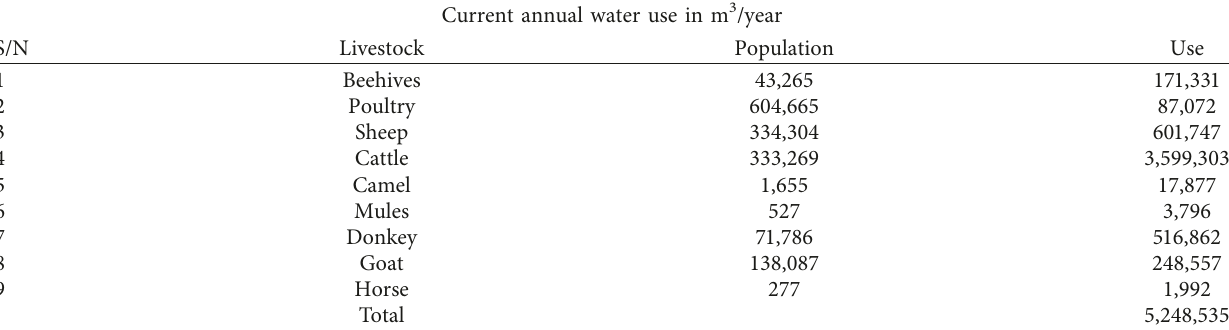
Table 11: Current total livestock population and water demand of the subbasin.